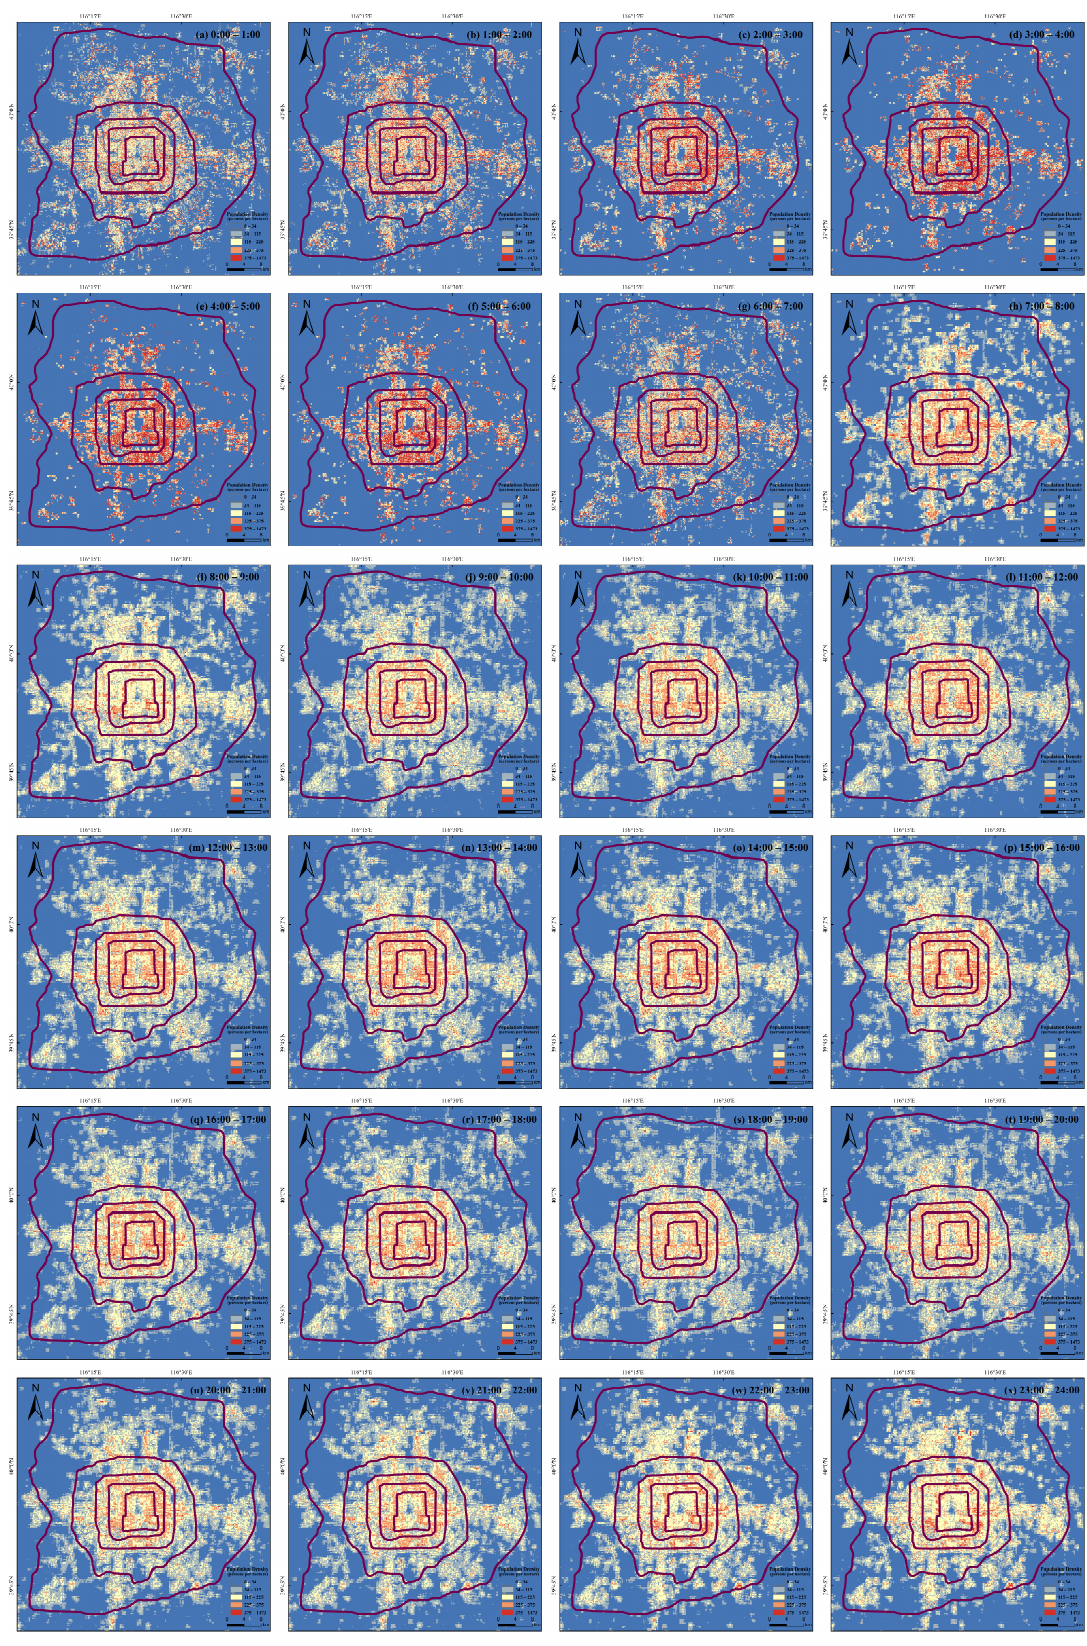
Figure 5. Estimated dynamic population distribution within the Sixth Ring Road in